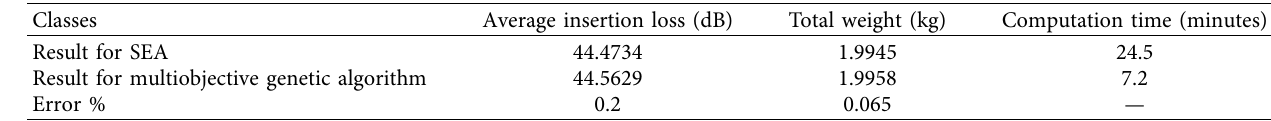
Table 10: Optimal values.